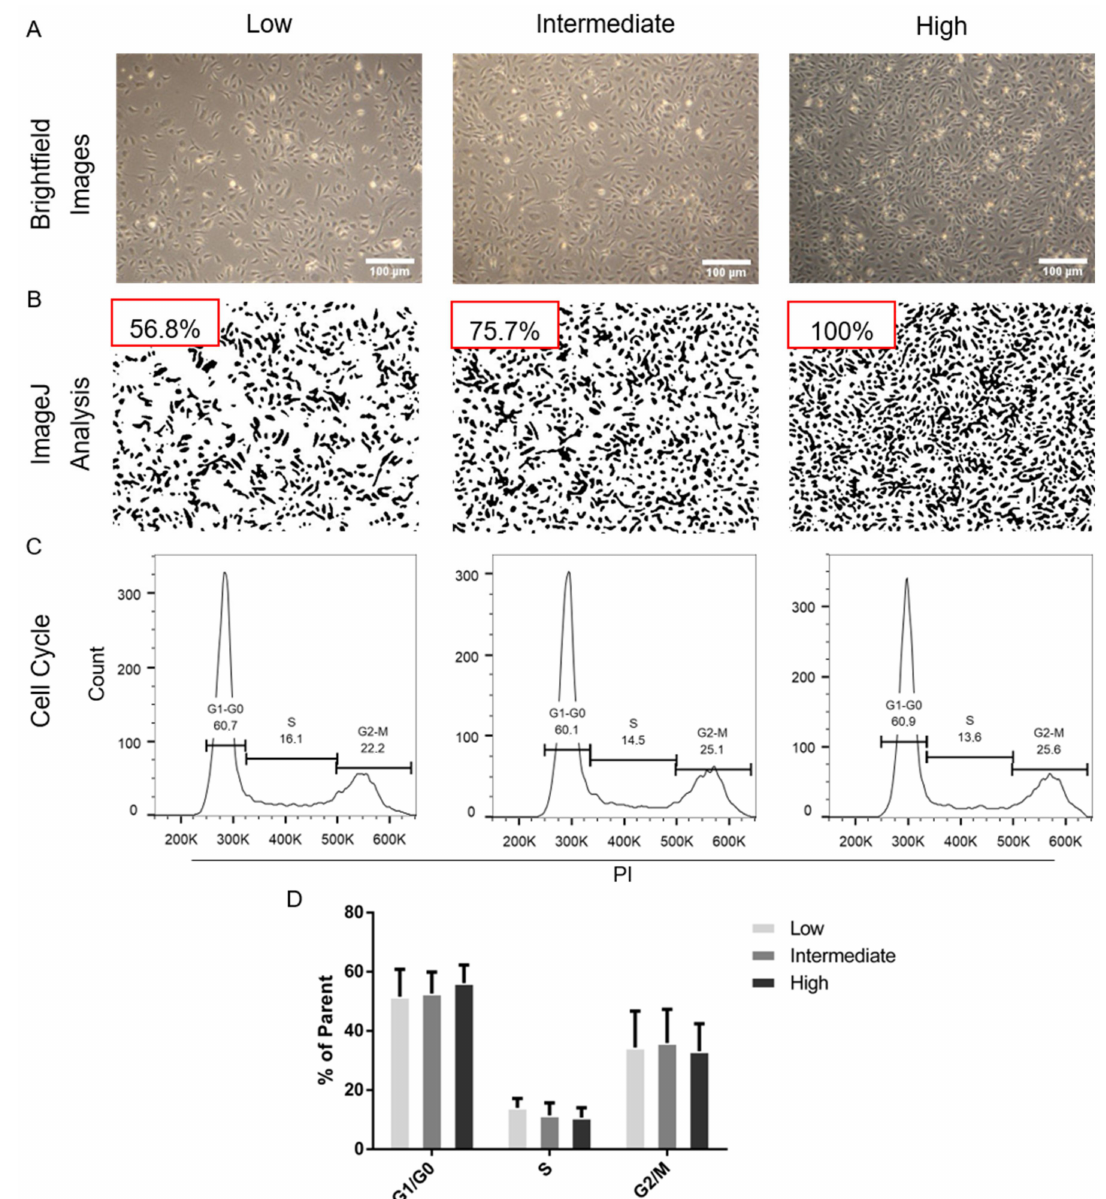
Figure 1. Achieved cell confluences and corresponding cell cycle distributions. Cell numbers for seeding were calculated to reach the respective confluences of 50–60% (Low), 70–80% (Medium) and 90–100% (High) after 24 h growth in endothelial growth medium (EGM-2). ( A ) Brightfield images of cell monolayers were obtained with 4 × magnification. White scale bars indicating 100 µ m. ( B ) Acquired images were analyzed using ImageJ to gain total surface coverage values for “Low” (56.8%) and “Medium” (75.7%) in relation to “High” (set as 100%). ( C ) Representative histograms plotted against propidium iodide fluorescence intensity of di ff erent confluence groups. ( D ) Quantification of the cell cycle distribution. “Low” shows mean values of 51.6% of the parent population in G1–G0, 14.0% in S and 34.4% in G2-M. 52.7% 56.2% in G1–G0, 11.5% and 10.7% in S and 35.9% and 33.1% in G2-M were detected for the “Intermediate” and “High” confluence groups, respectively. EGM-2 figure endothelial growth medium; ( A – C ) representative samples, ( D ) n = 2 cell